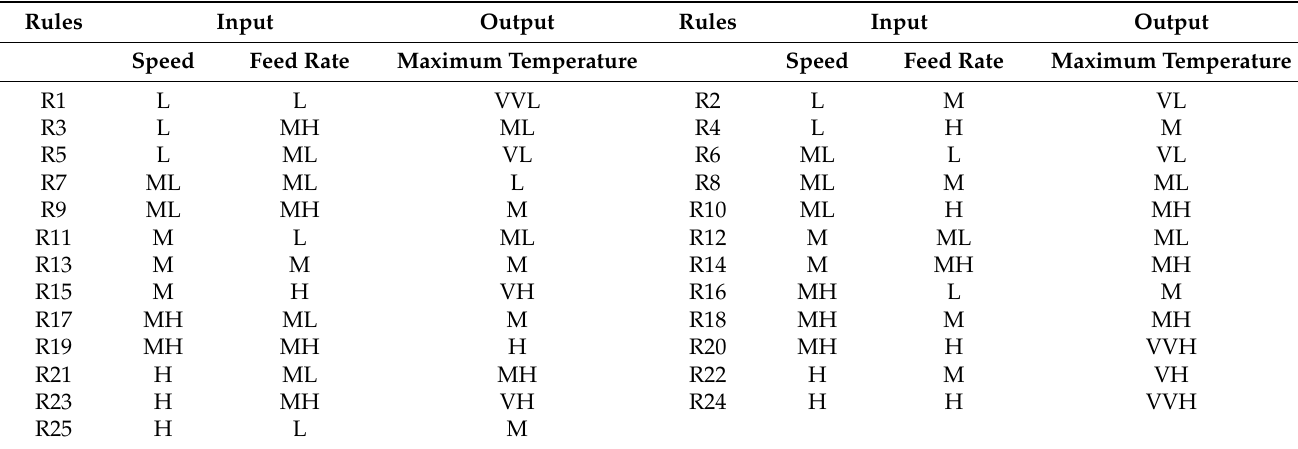
Table 2. The fuzzy rules developed for the current